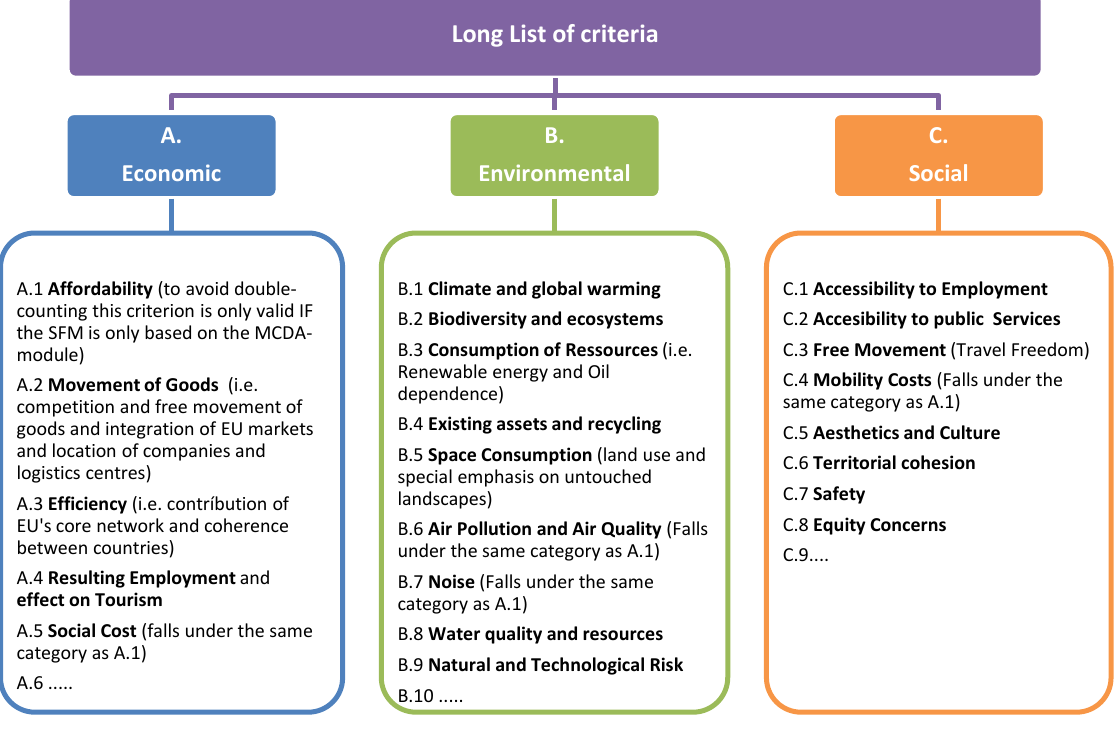
Figure 2. Excerpt of the Long List of criteria elaborated with respect to the three traditional pillars of sustainability: economic, environmental and social (adapted from Salling and Pryn (2015) and Pryn